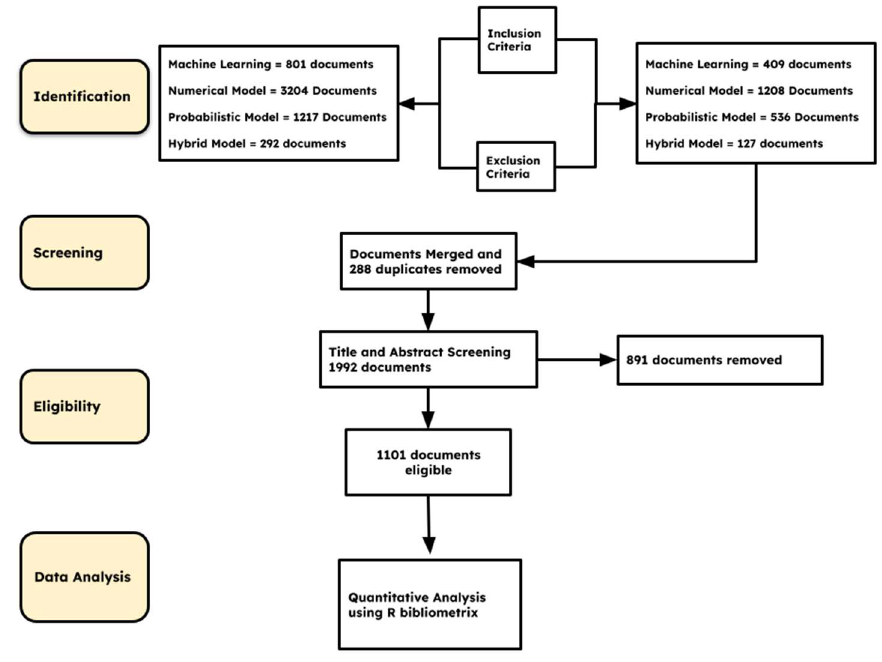
Figure 2. Illustration of the search strategy for this review study.